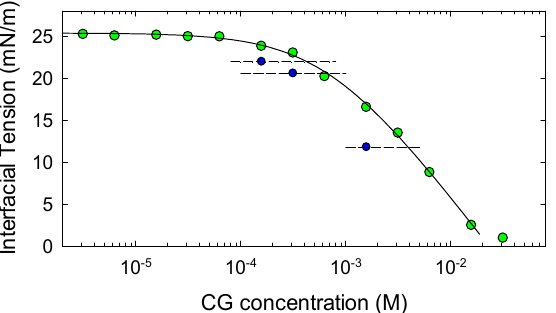
Figure 6. Equilibrium interfacial tension versus molar CG concentration in MCT (blue symbols) and in water (green symbols).